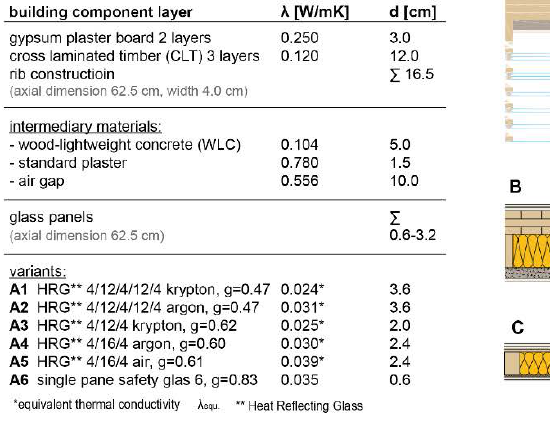
Fig. 3 Structure of the simulation model.